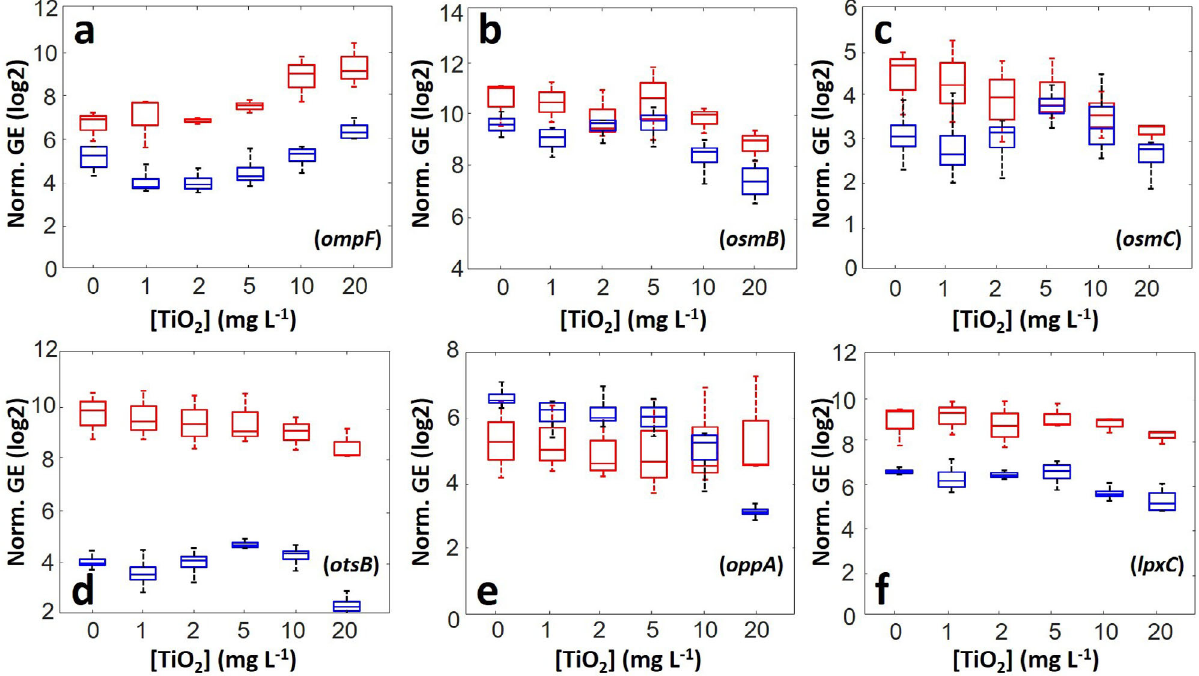
Fig. 9 Transcriptomics evidences dominant osmotic stress generated by TiO 2 NPs. Expression levels of genes ( a: ompF , b: osmB , c: osmC , d: otsB , e: oppA , f: lpxC ) involved in the osmotic stress-response of JW3606 (hep + ) (blue) and JW3596 (hep − ) (red) as a function of TiO 2 NP concentration, and represented in the form of box plots ( n = 4 for each condition tested). The normalized gene expression (norm. GE) was calculated from the ratio between the intensity of the targeted gene and the geometric mean intensity of reference genes. Statistical signi fi cance testing and p -values are provided in the Supplementary